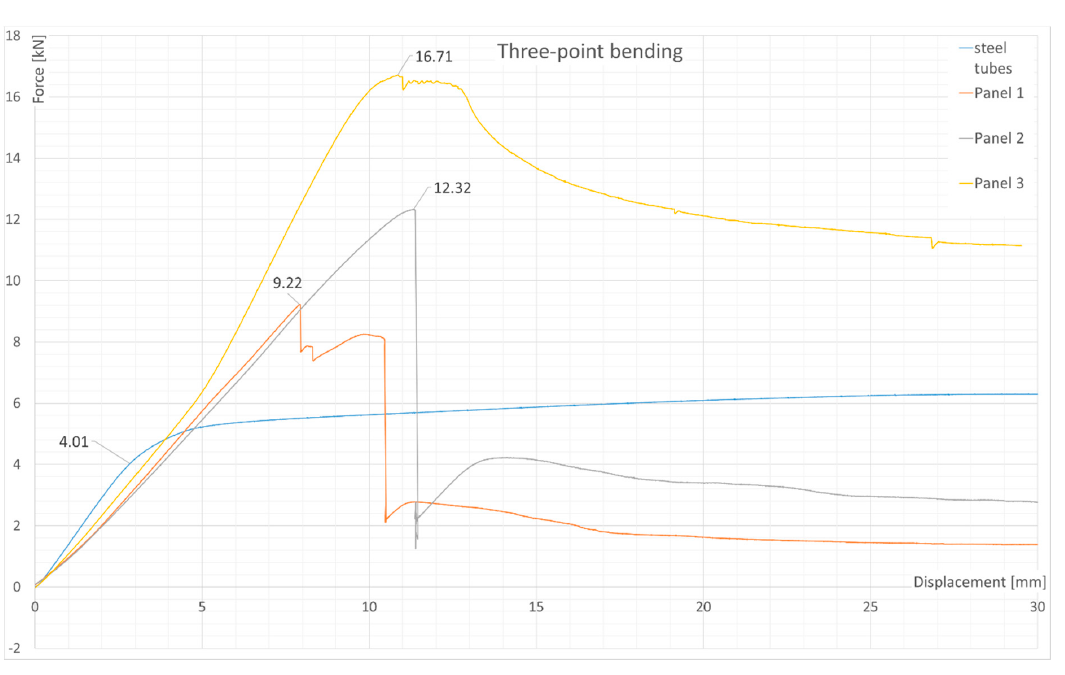
Table 3. Results of three-point bending test.